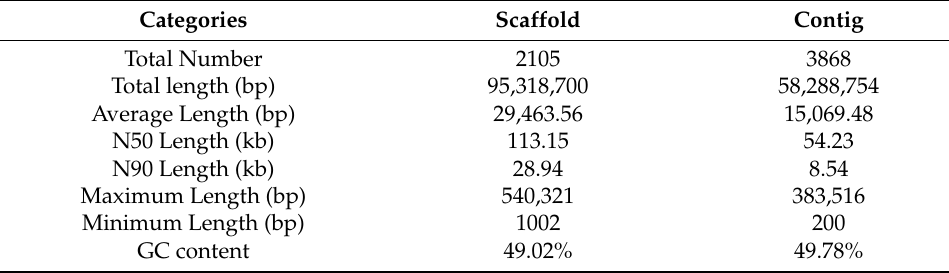
Table 1. Genomic features of Phytophthora nicotianae